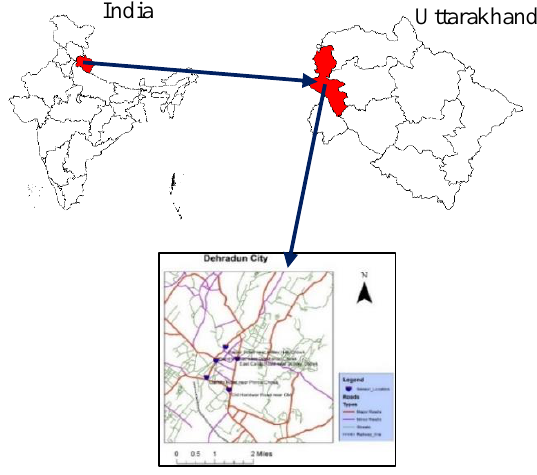
Figure 6. Map of Study Area with installed sensor locations